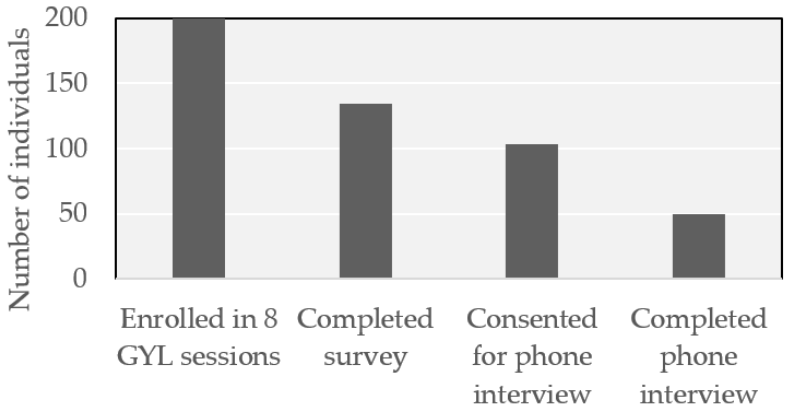
Figure 3. Survey and phone interview participants.